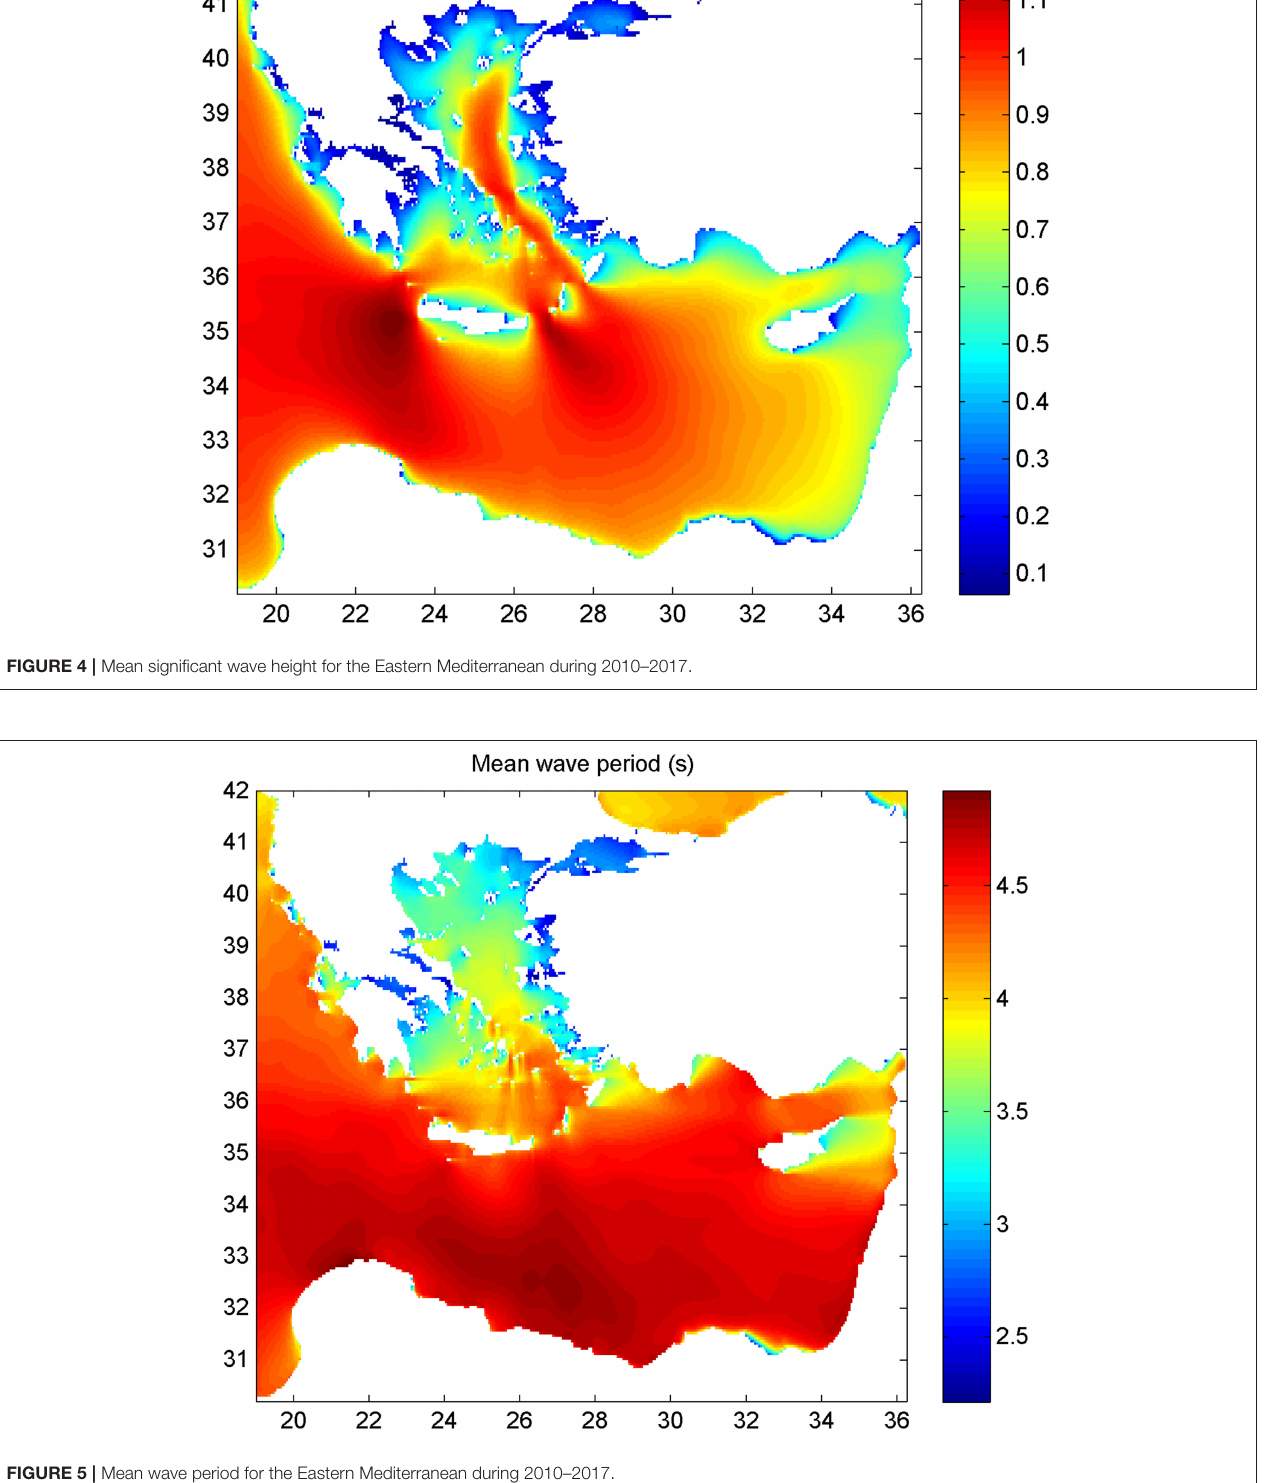
FIGURE 5 | Mean wave period for the Eastern Mediterranean during